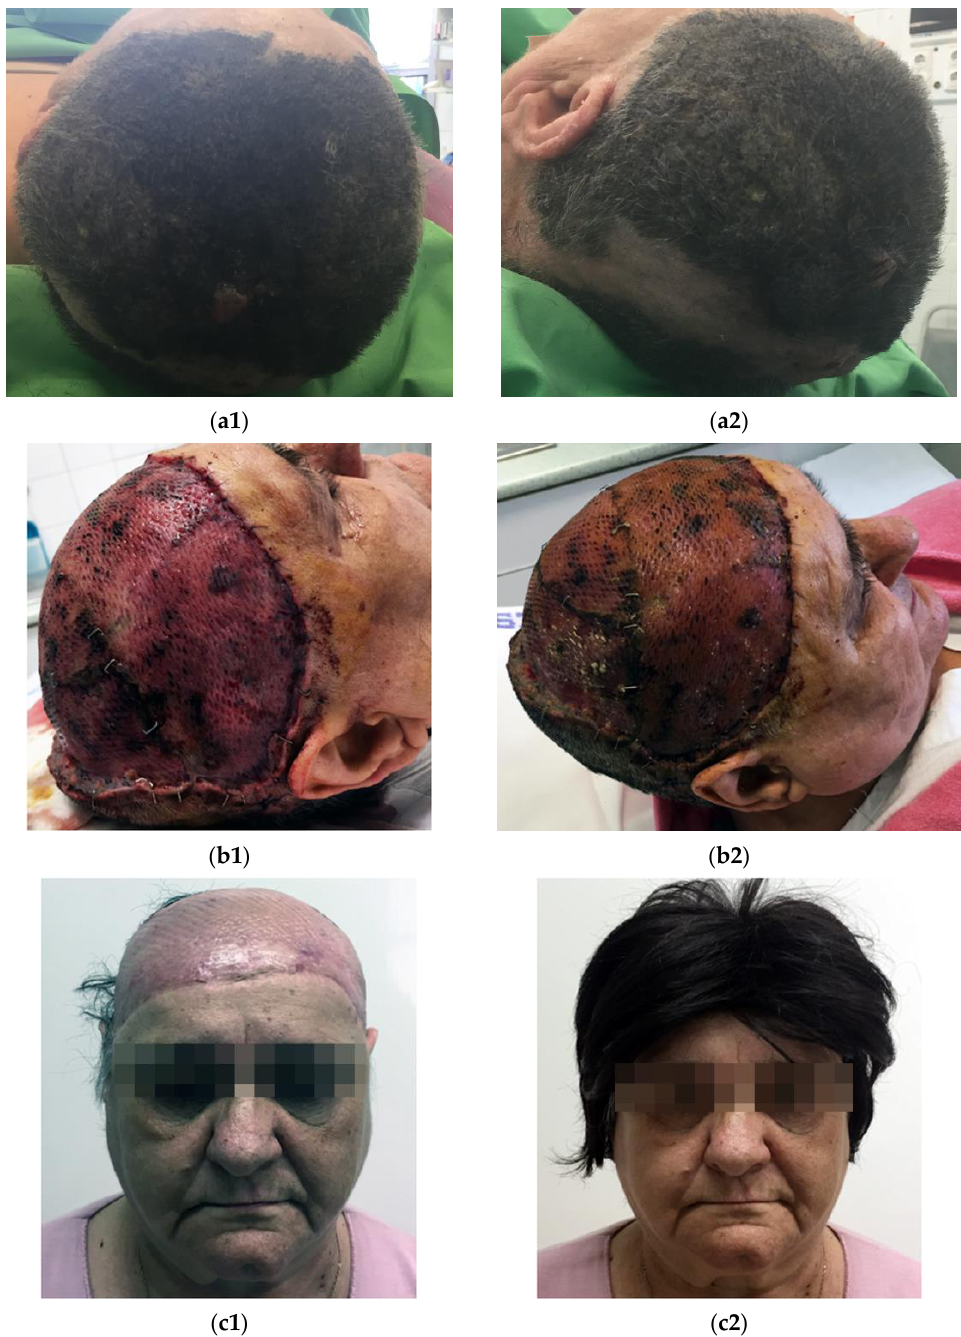
Figure 4. ( a ) Giant melanoma of the scalp preoperatively; ( b ) two-week follow-up, healed mesh skin graft; ( c ): six-month follow-up.